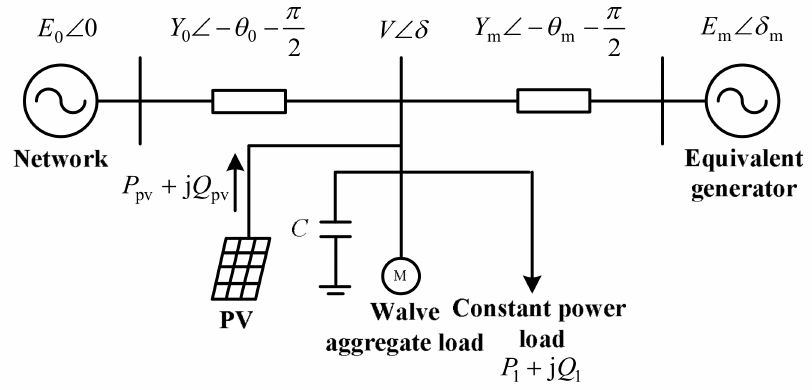
Figure 2. The three-node system with a large-scale photovoltaic cell (PV) power